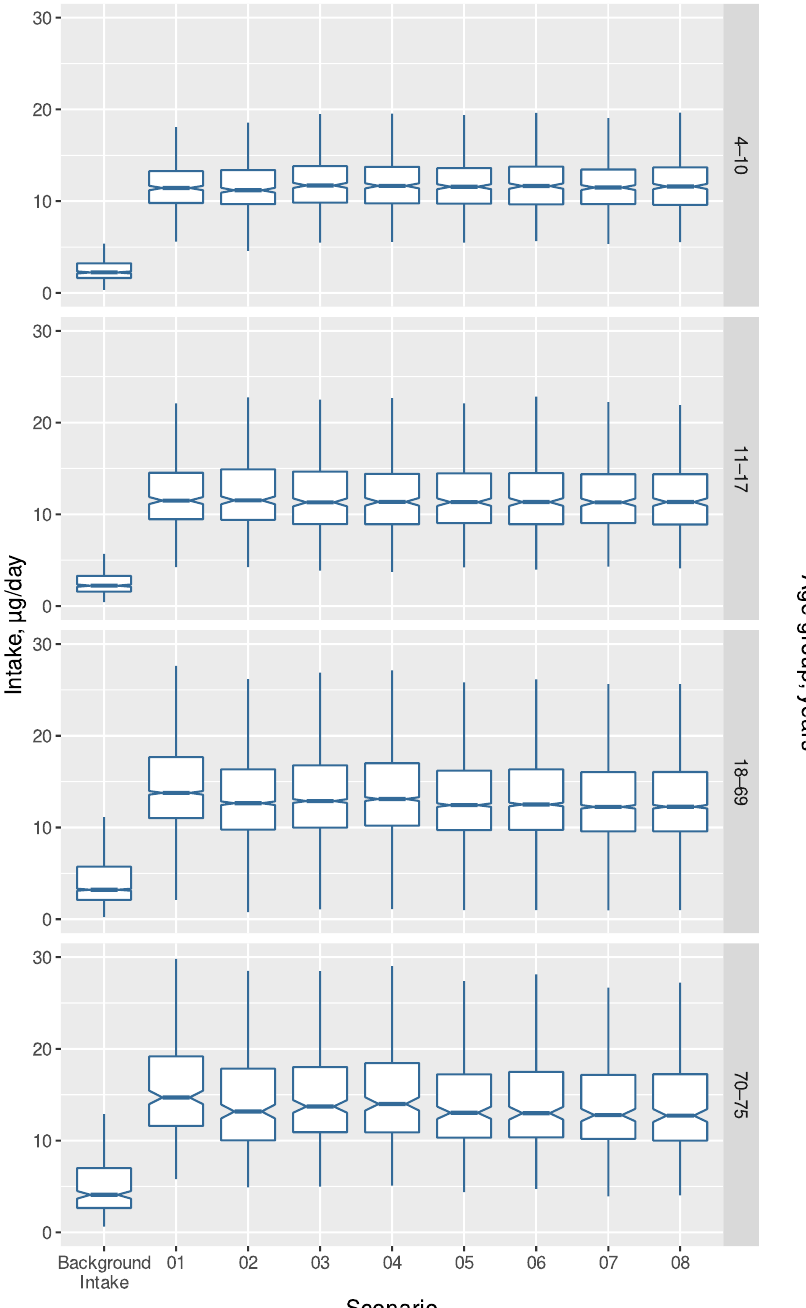
Figure 1. Calculated intake of vitamin D ( µ g/day) for background intake and the eight optimized scenarios by four age groups using individual food intakes from DANSDA. Scenarios are described in Table 1.